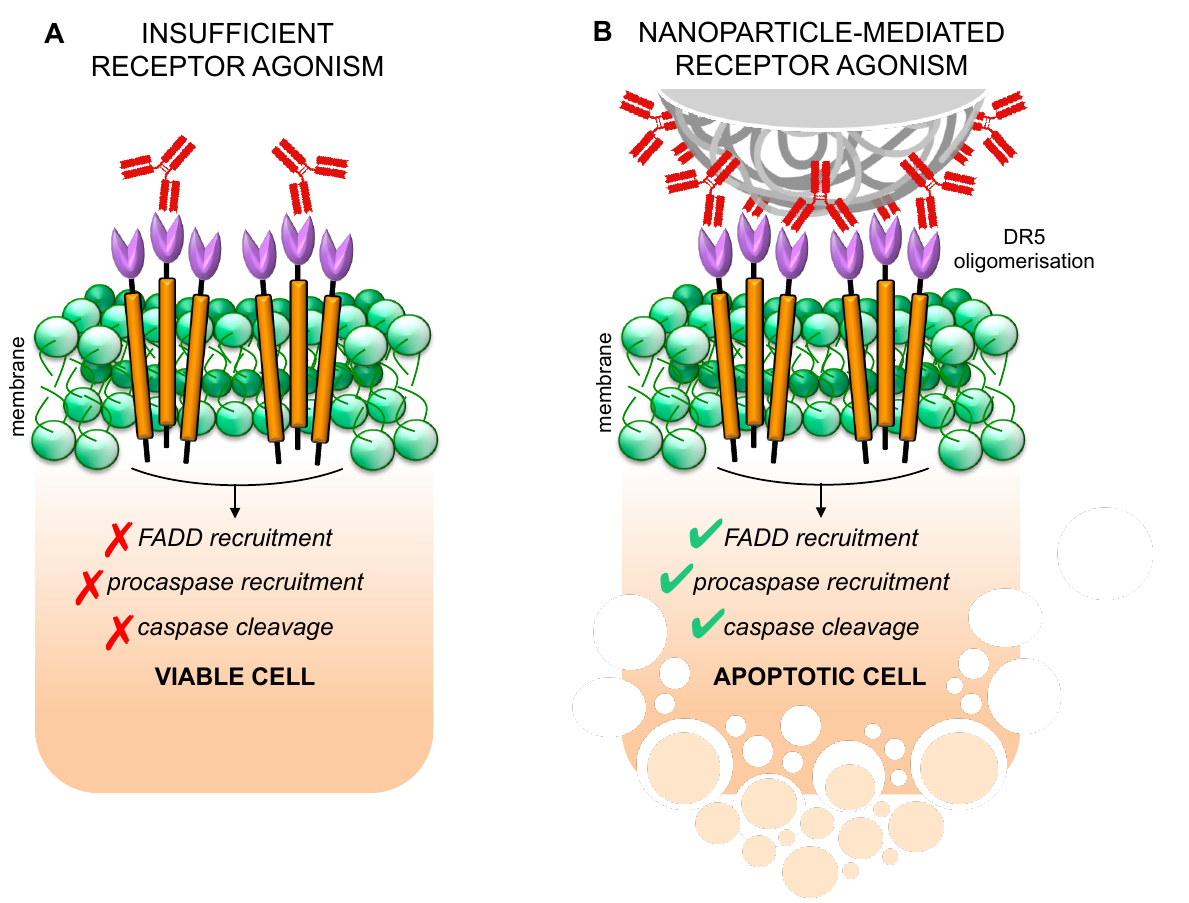
Figure 3. Multivalent antibody presentation on the surface of nanoparticles facilitates receptor activation. Insufficient agonism of target receptors represents a common mode of resistance to many therapies, as observed with antibodies directed against DR5, for example. ( A ) When applied in free format, antibodies show limited ability to induce oligomerisation and cross-linking of DR5 to the extent required for downstream signal transduction. ( B ) However, the concentrated display of antibodies on a nanoparticle surface allows for multivalent engagement of DR5 beyond the threshold needed for receptor activation. Signalling is initiated in response, involving recruitment of FADD and activation of initiator and executioner caspases that mediate apoptotic cell